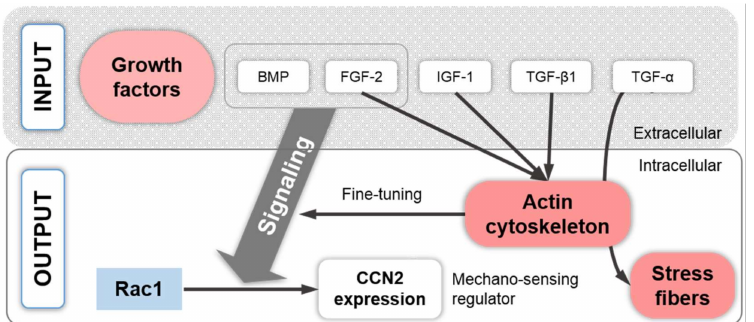
Figure 7. Correlation between growth factor signaling, the actin cytoskeleton, and CCN2 expression in CHs. The actin cytoskeleton modulates FGF-2 and BMP signaling through the Rac1 pathway, affecting the expression of CCN2 that functions as a mechano-sensing regulator [238]. The CH actin cytoskeleton is regulated through the signaling of the growth factors FGF-2, IGF-1, TGF- β 1, and TGF- α . The latter may induce stress fiber formation. Abbreviations: BMP: bone morphogenetic protein, CCN2: connective tissue growth factor, FGF-2: fibroblast growth factor 2, IGF-1: insulin growth factor I, TGF- α : transforming growth factor α , TGF- β 1: transforming growth factor β 1. Arrows indicate